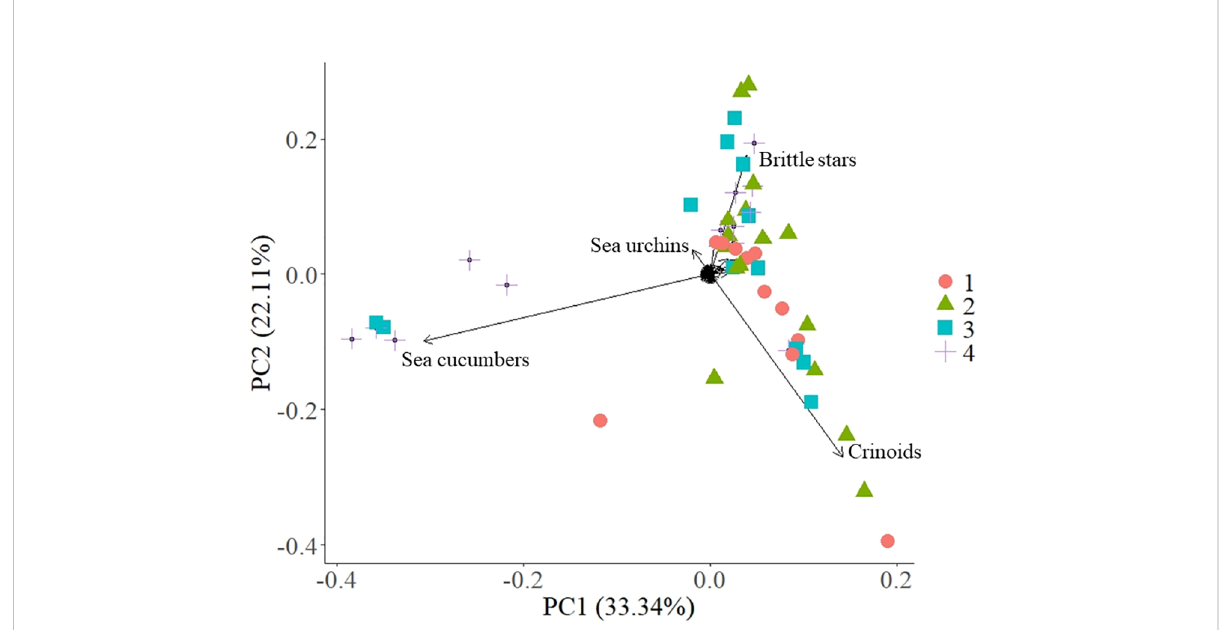
FIGURE 8 Principal components analysis comparing community composition by morphotype (common name) at different rugosities in waters off Jarvis Island (NOAA Ocean Exploration EX1705), with 1 being the smoothest sea fl oor and 4 being the most structurally complex topography. Loadings show the contributions of taxa that most strongly drive community differences between